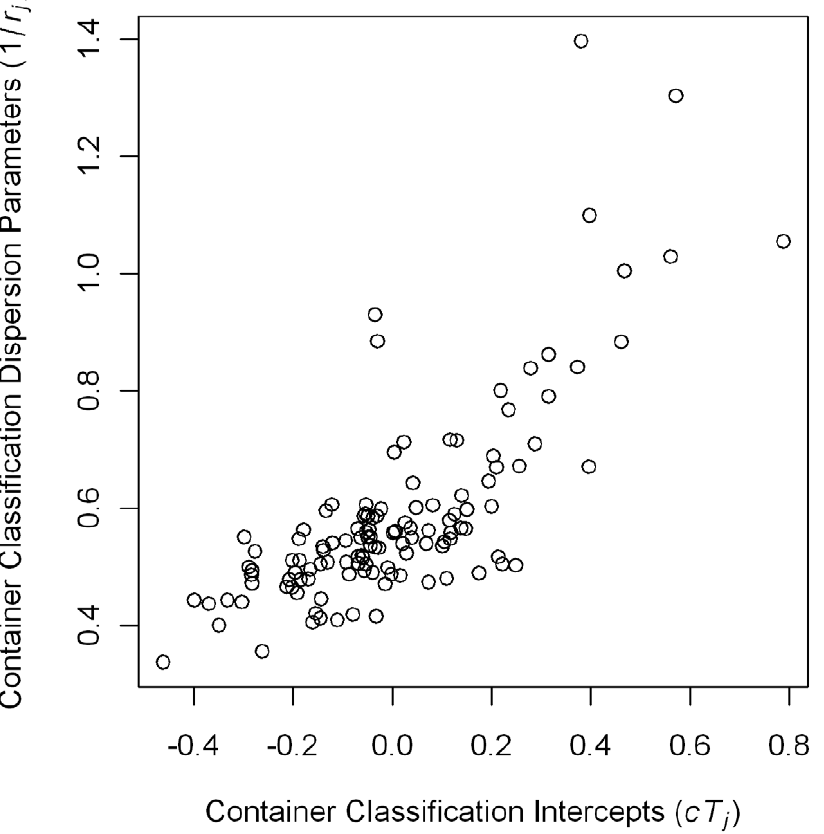
Figure 8. The relationship between container classification group intercepts and dispersion parameters. The container classification group intercepts and dispersion parameters for the negative binomial portion of the hurdle regression model.